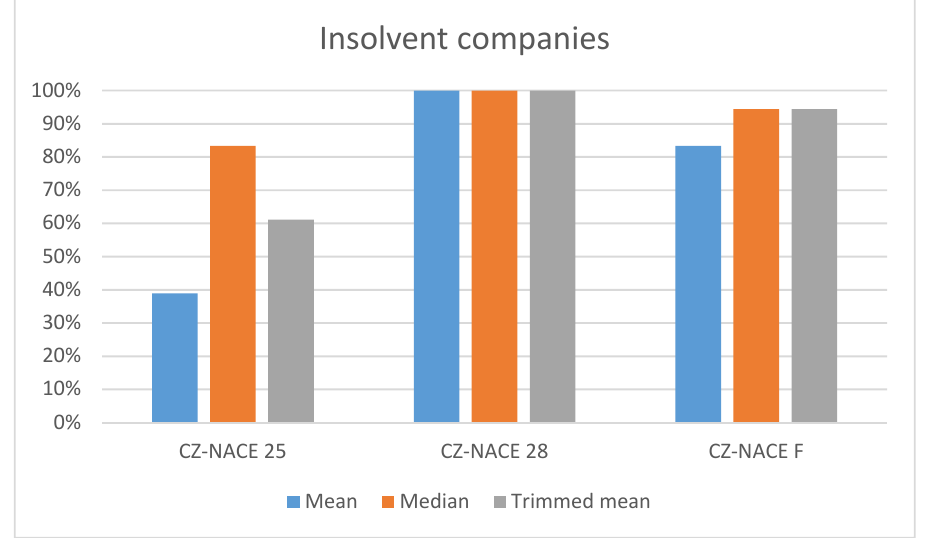
Figure 6. The number of models within each branch confirming better conditions for insolvent companies. Source: authors’ own work.